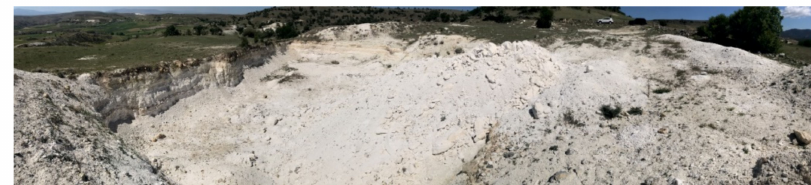
Figure 2. Quarry view of the Seydiler (Afyon-Turkey) diatomite.